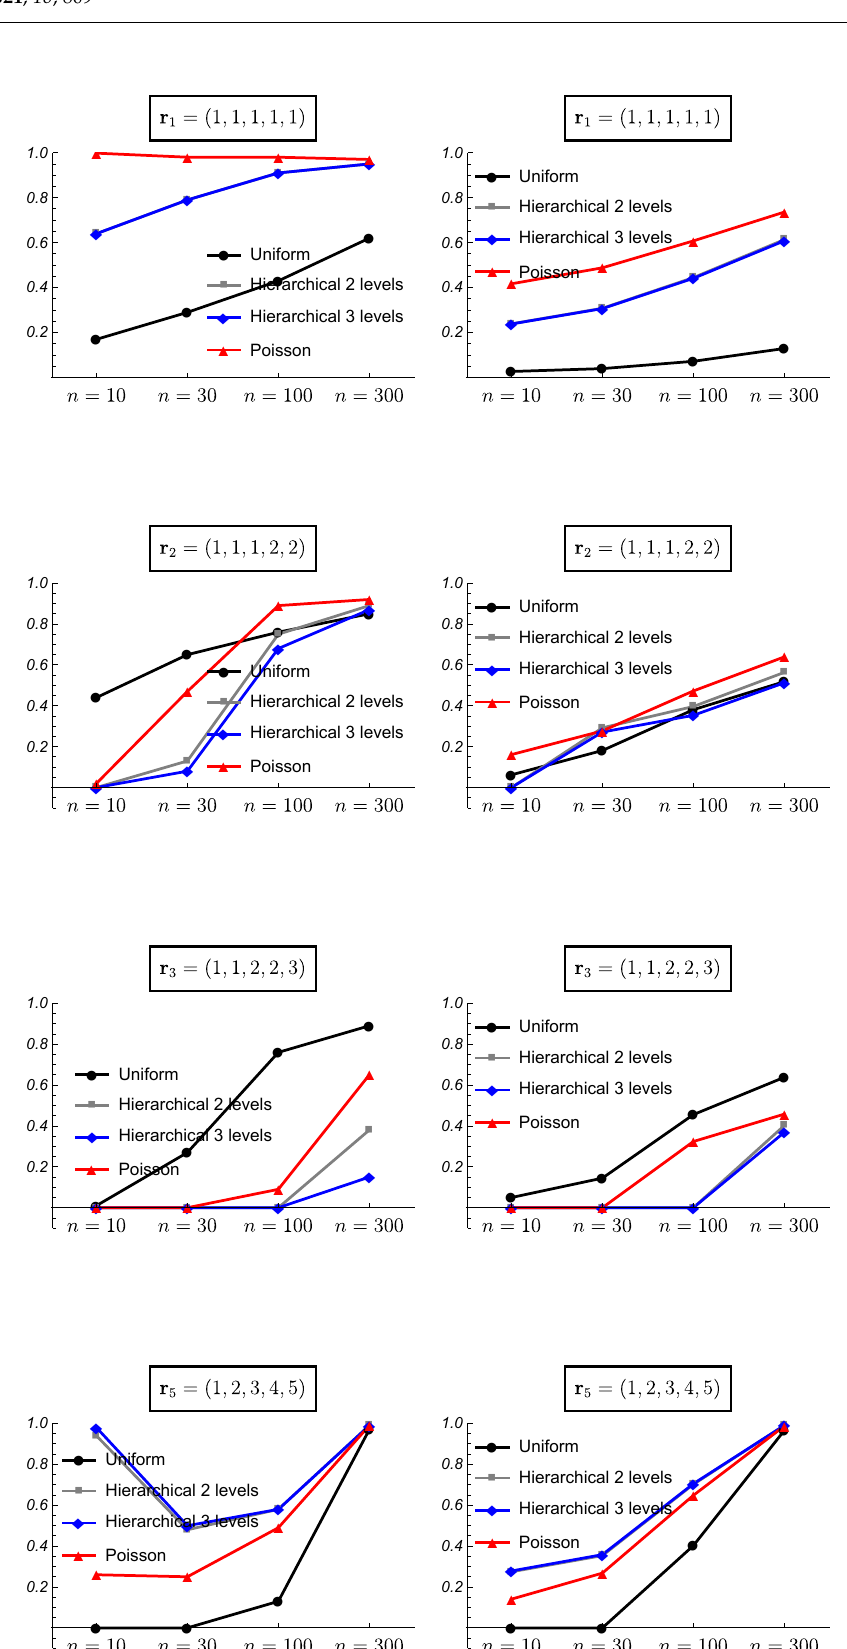
Figure 8. Frequentist validation for the case k = 5 and true partitions r 1 = ( 1,1,1,1,1 ) , r 2 = ( 1,1,1,2,2 ) , r 3 = ( 1,1,2, 2,3 ) , and r 5 = ( 1,2,3, 4,5 ) . ( Left column ) proportion of times the true partition is found as the most probable. ( Right column ) mean of the posterior probability for the true partition when it is found as the most